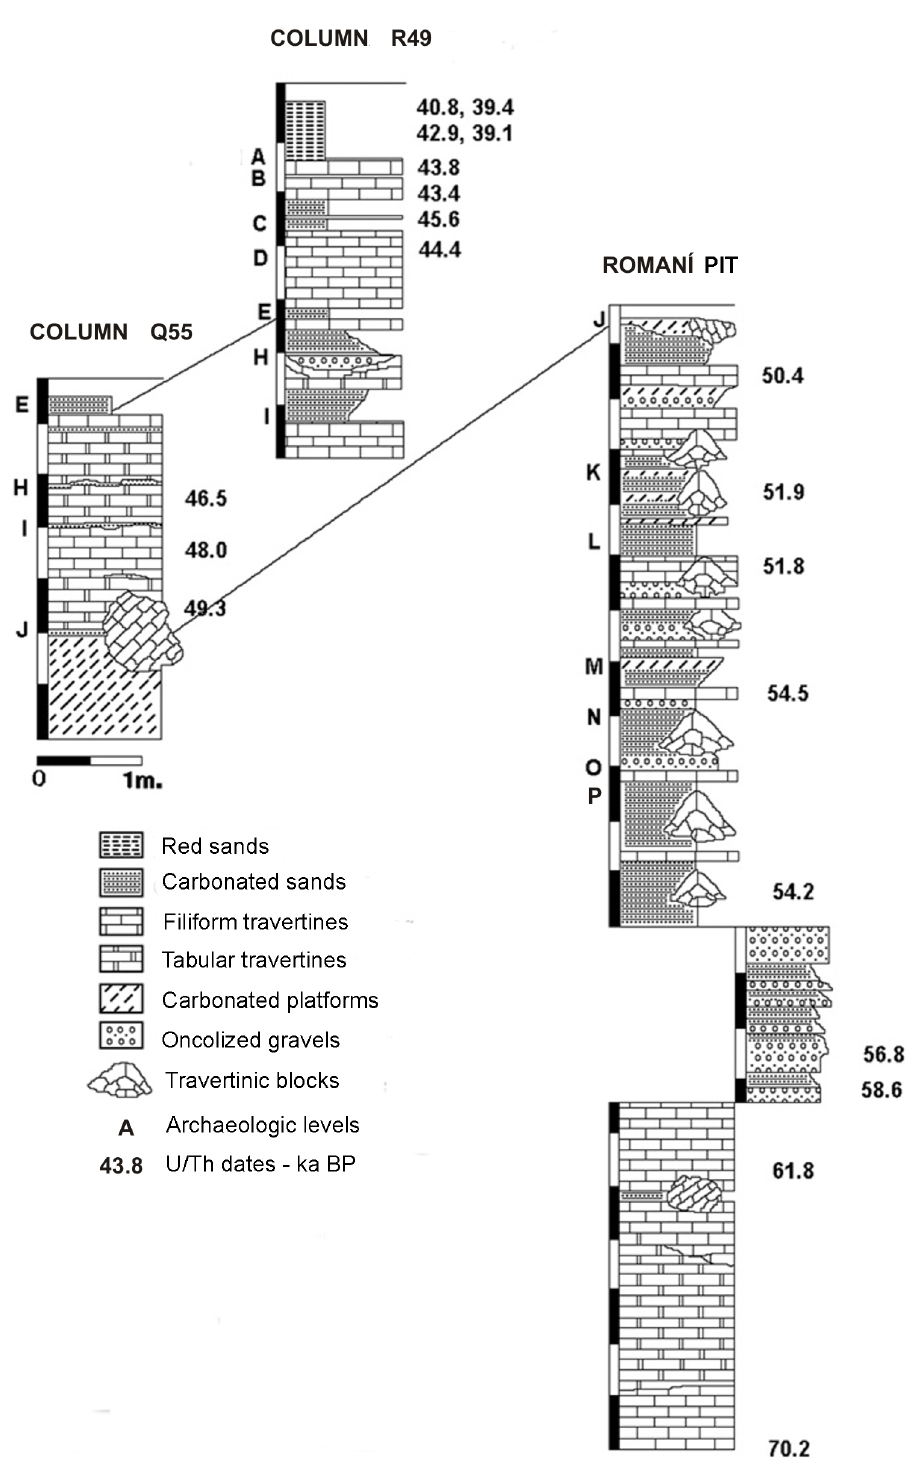
Figure 10. Stratigraphic secuence of the Abric Romaní (modified from Giralt & Julià